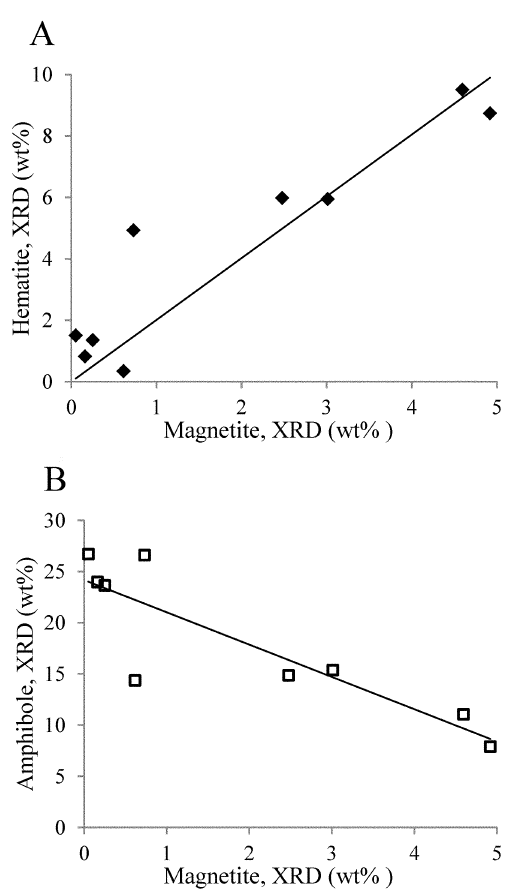
Fig. 4. The positive correlation between Lemme magnetite and hematite ( A ) and the negative correlation between Lemme magnetite and amphiboles ( B